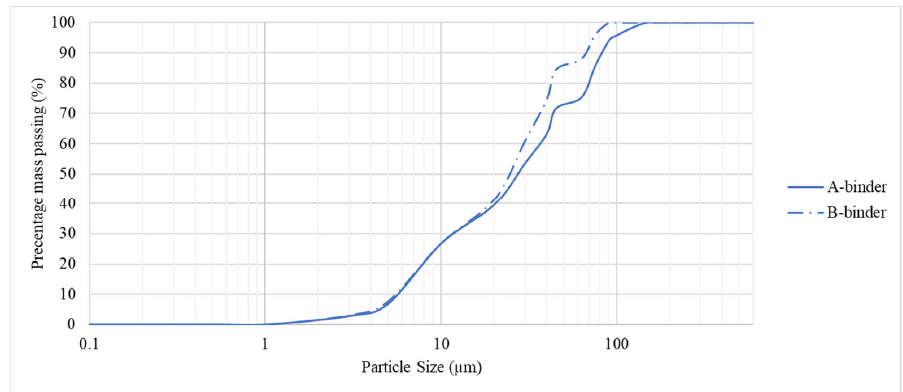
Figure 4. Particle size distribution curves of A ‐ binder and B ‐ binder used in the compaction process. Table 1. Feed composition for dry granulation, feed moisture, and ribbon